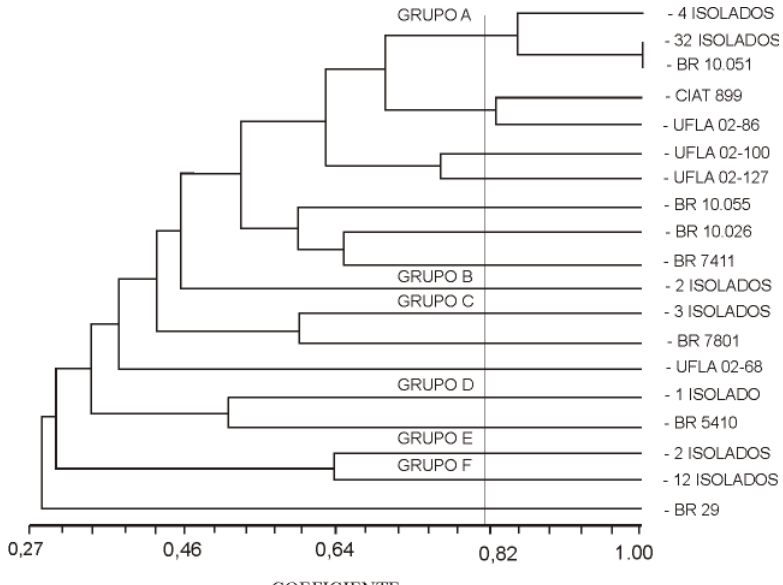
Figura 1. Dendrograma de similaridade construído com base nos perfis de proteína celular total de estirpes isoladas do solo da área em estudo, das estirpes inoculantes (CIAT 899, UFLA 02-68, UFLA 02a-86, UFLA 02-100 e UFLA 02-127) e das estirpes tipo ER 316ci0a T (BR 10.051- Rhizobium leguminosarum bv phaseoli); CNF 42 T (BR 10.026- Rhizobium etli); HAMBI 540 T (BR 10.055- Rhizobium galegae bv orientalis); NZP 4027 T (BR 7411- Sinorhizobium meliloti ); NZP 2213 T (BR 7801- Mesorhizobium loti ); ORS 571 T (BR 5410- Azorhizobium caulinodans) e referência BR 29- Bradyrhizobium elkanii ., obtidas por eletroforese em gel de poliacrilamida (SDS-PAGE).